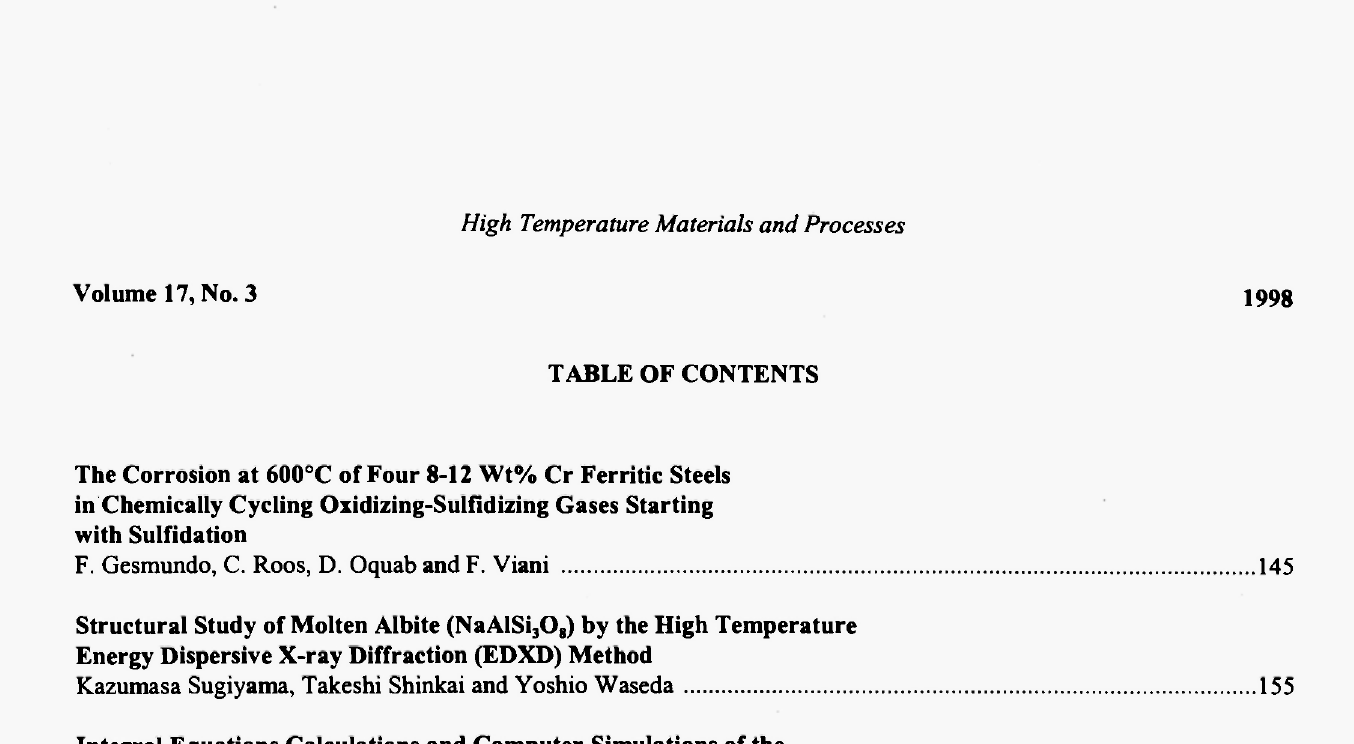
The Corrosion at 600°C of Four 8-12 Wt% Cr Ferritic Steels in Chemically Cycling Oxidizing-Sulfldizing Gases Starting with